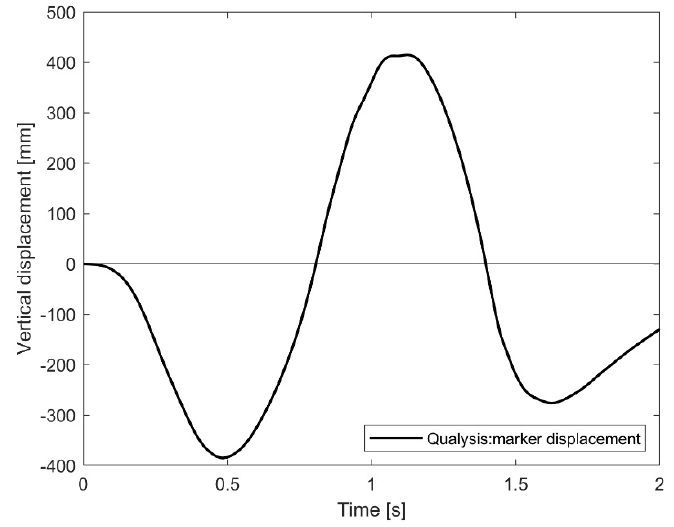
Figure 2. Vertical displacement of single hip marker measured using QMS.